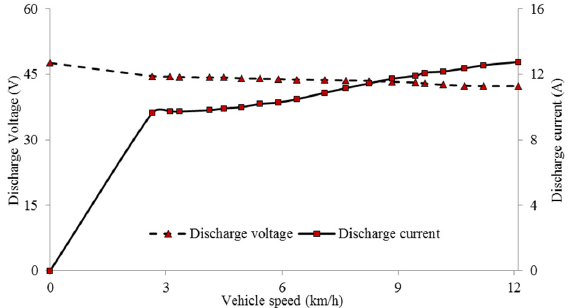
Figure 5. Discharge voltage and current trends at 390 kg load.